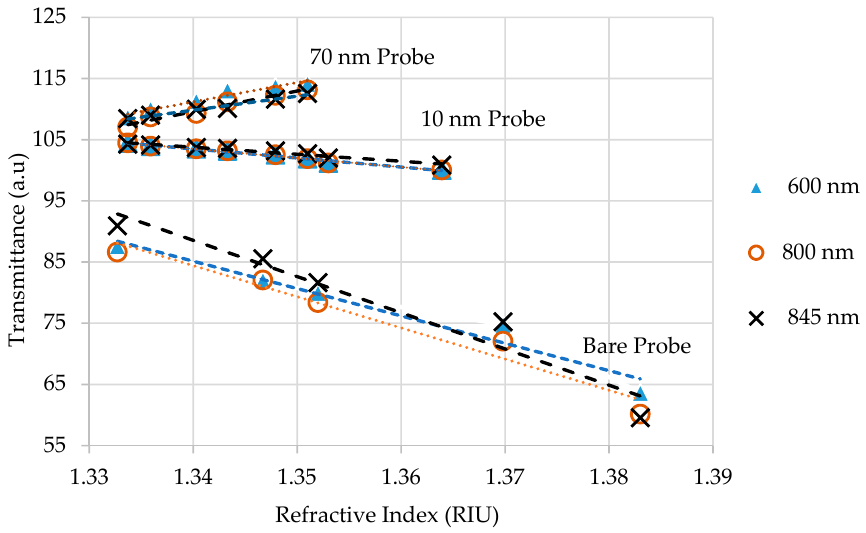
Figure 8. Sensor responses for RI variations using Setup 2 for wavelengths 600 nm, 800 nm and 845 nm for bare probe, 10 nm gold-coated probe and 70 nm gold-coated probe. Table 2. Summary of the biosensors sensitivities and maximum expanded uncertainties (95% confidence level) in the Setup 2.